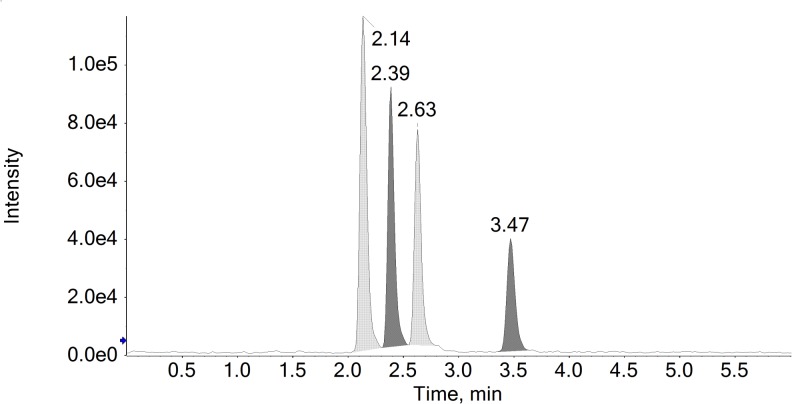
Representative Total Ion Chromatogram (TIC) obtained for the hormones.The elution sequence from left to right is cortisol (2.14 min), estradiol (2.39 min), testosterone (2.63 min), and progesterone (3.47 min).